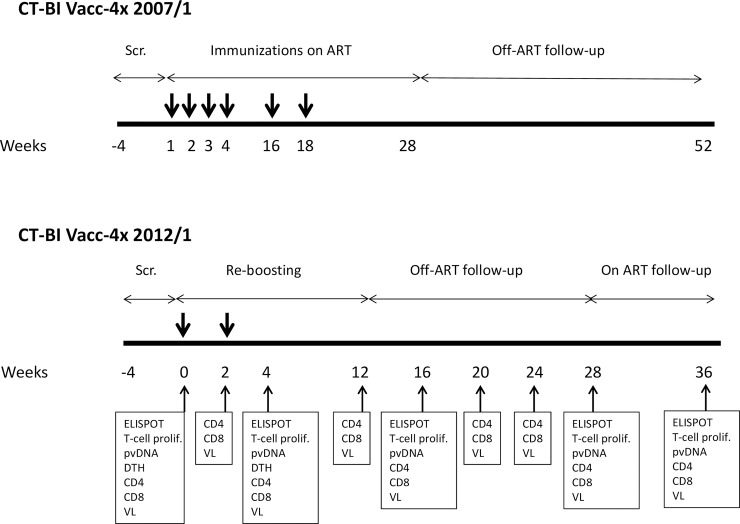
Study schedule for CT-BI Vacc-4x 2007/1 and CT-BI Vacc-4x 2012/1 clinical studies.Thick arrows indicate Vacc-4x immunizations. Analyses carried out during the 2012/1 clinical study are shown. Scr.: Screening; ELISPOT: Enzyme-linked Immunosorbent Assay; T-cell prolif.: T-cell proliferation; pvDNA: proviral DNA; DTH: Delayed type hypersensitivity; CD4 and CD8 T-cell counts; VL: viral load.